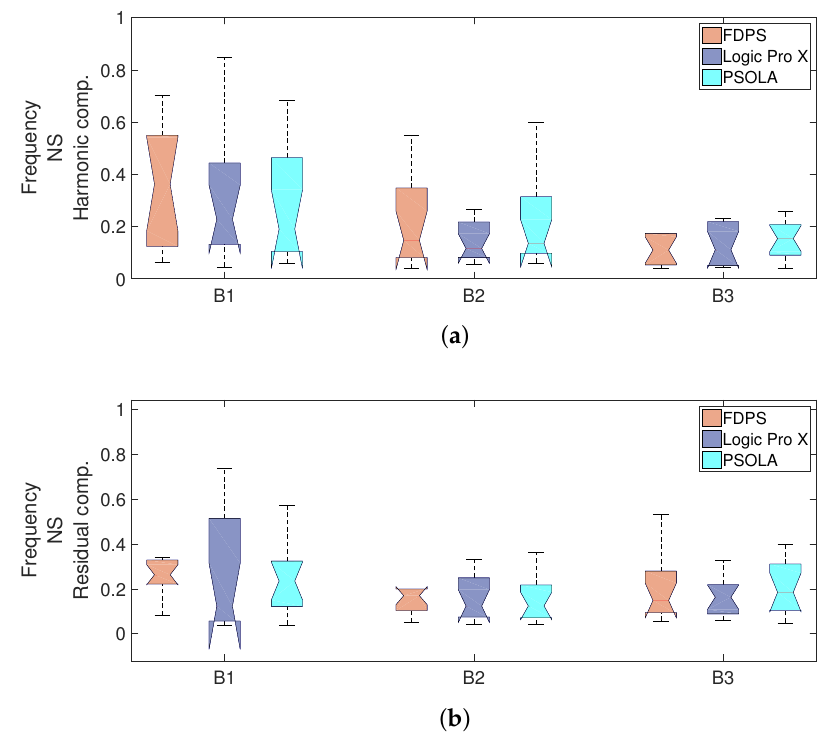
Figure 13. Normalized similarity of the bandwidth of the first three formants. ( a ) Harmonic component; ( b ) residual